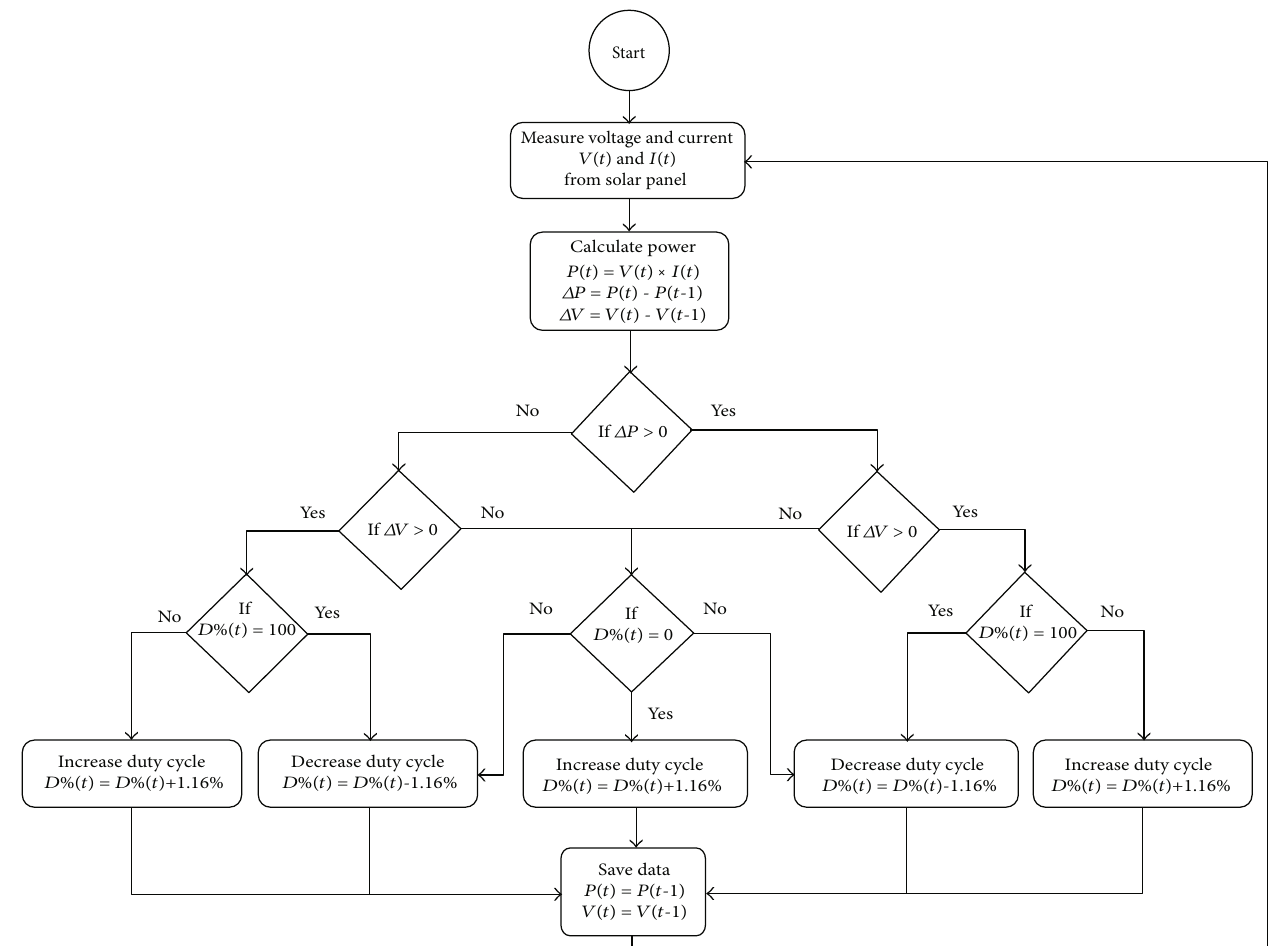
Figure 8: Flow chart of the designed MPPT